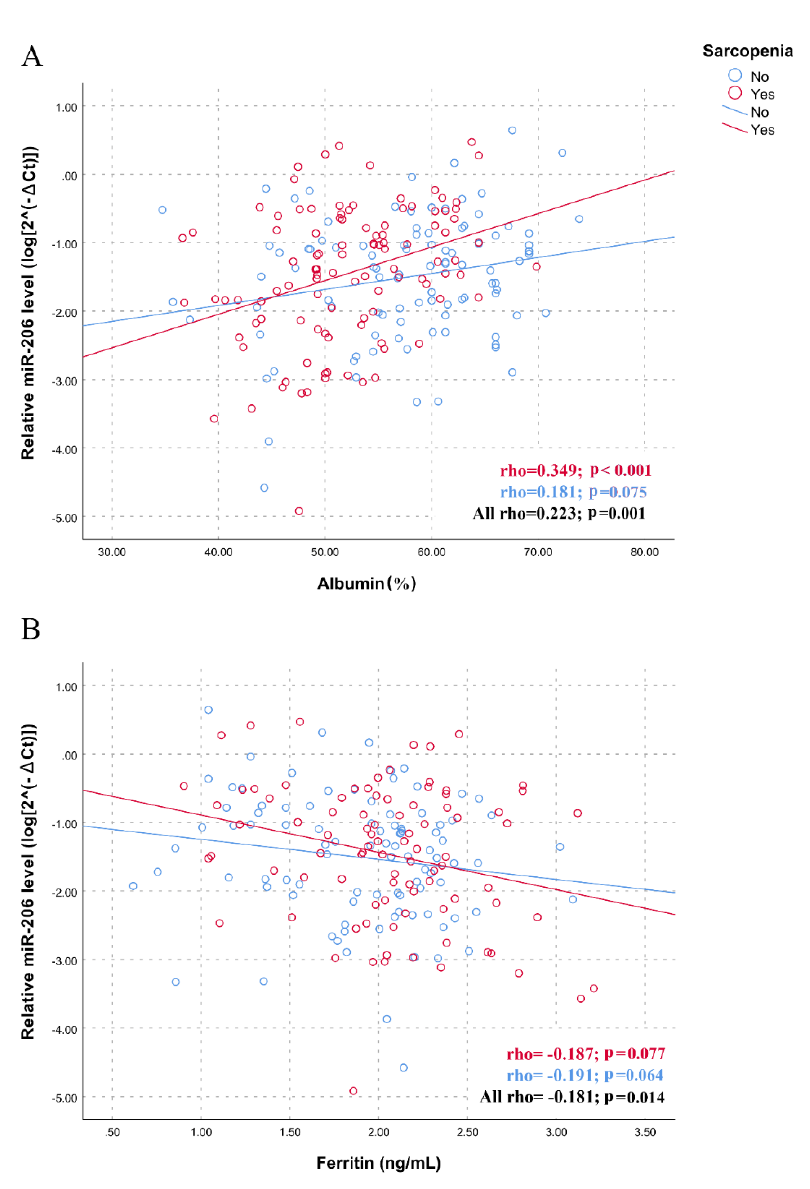
Figure 4. Correlations between plasma miR-206 levels and biochemical variables in sarcopenic and non-sarcopenic subjects. Scatter plots illustrate the relationship between plasma miR-206 levels and ( A ) albumin, ( B ) ferritin. Data are reported as log 2 −∆Ct normalized to U6 expression.